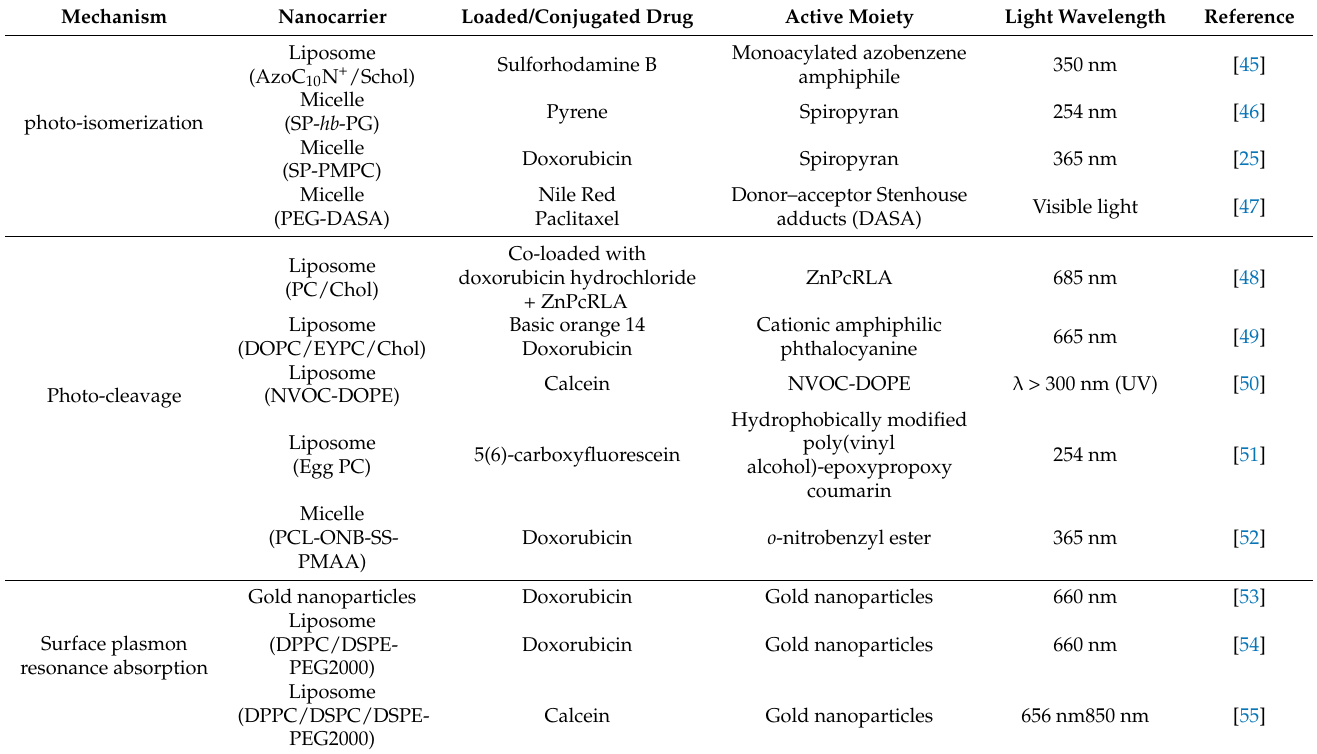
Table 2. Photo-triggered drug release in-vitro